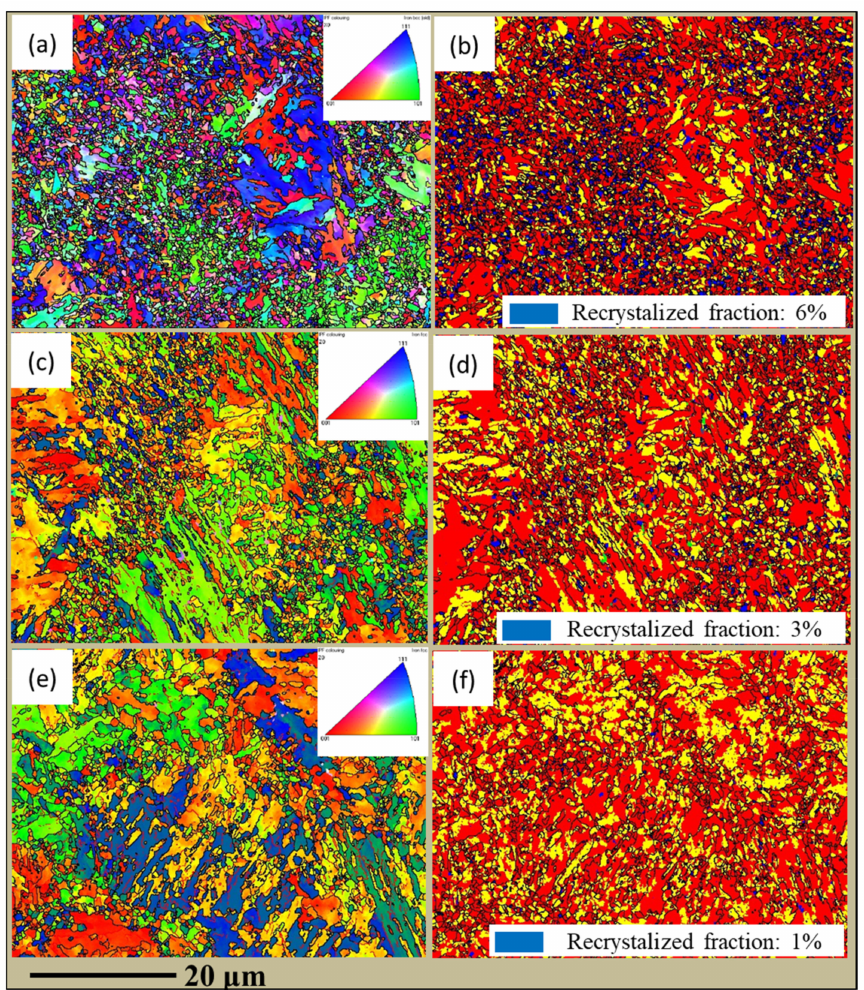
Figure 11. Inverse pole figures and recrystallized grains distribution of SLM low-alloy steel samples grown with di ff erent EADs: ( a , b ) EAD = 142 J / mm 2 ; ( c , d ) EAD = 71 J / mm 2 ; ( e , f ) EAD = 47 J / mm 2